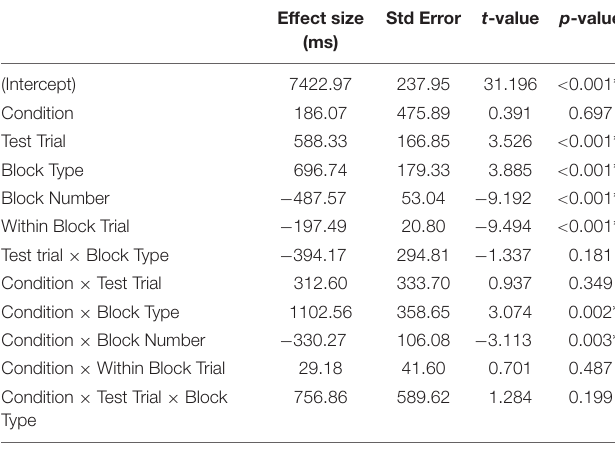
TABLE 1 | Fixed effects of the regression model.